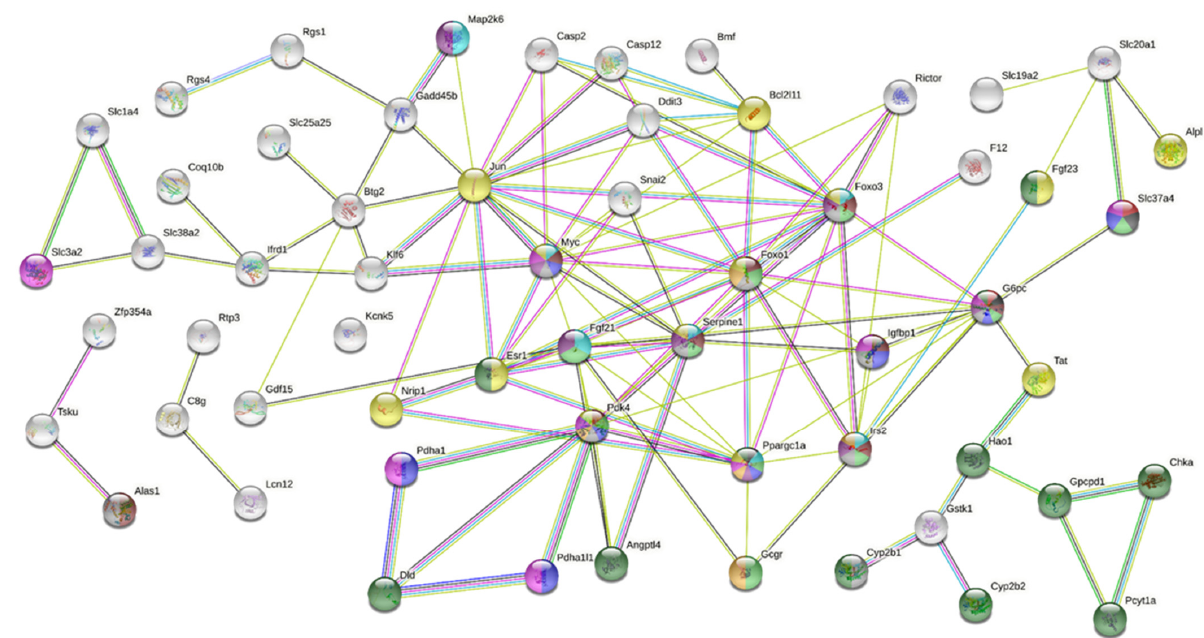
Figure 5. Functional enrichment analysis by STRING. Biological processes, color (pantone hex code): gluconeogenesis, dark gray (#53565a); glucose ‐ 6 ‐ phosphate transport, red (#c1232d); glucose metabolic process, blue (#0026ab); glucose homeostasis, light green (#9dd38b); response to carbohydrate, purple (#634177); cellular response to carbohydrate stimulus, turquoise (PMS 3115 C; #00c1d4); regulation of cellular carbohydrate metabolic process, yellow mustard (#e1ad01); carbohydrate metabolic process, pink (#d62598); cellular response to insulin stimulus, ruby wine (#77353d); response to insulin, light gray (#c5c6c7); response to lipid, yellow (#ffe957); lipid metabolic process, dark green (#284d1c).